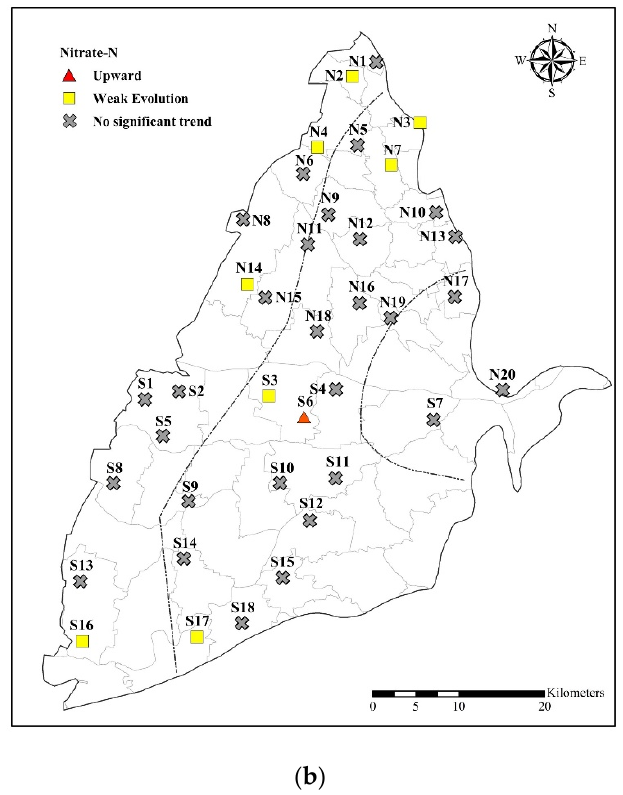
Figure 7. Spatial distribution of recent trends in ( a ) ammonium–N and ( b ) nitrate–N concentrations for each monitoring well in the study area.